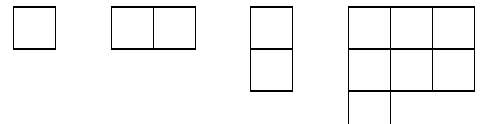
Figure 5 . Examples of Young diagrams corresponding to J µ , T µν (symmetric), F µν (antisymmetric) and Φ . In this last case, we also symmetrize over ( µ 1 ν 1 σ 1 ) and over ( µ 2 ν 2 σ 2 ) [ µ 1 µ 2 µ 3 ][ ν 1 ν 2 ][ σ 1 σ 2 ]